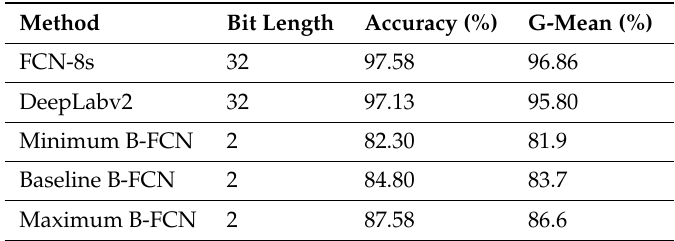
Figure 6. Compare the different floor segmentation method results. Table 4. Different methods of floor segmentation result point using on